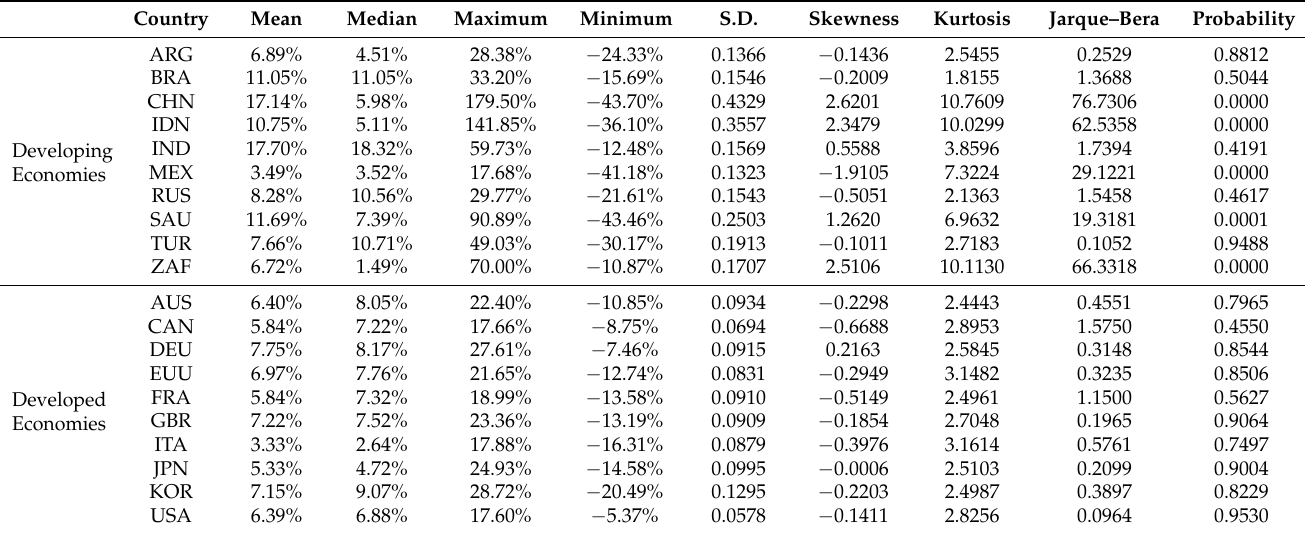
Table 4. Summary statistics of the commercial service export growth rate for the G20 countries from 1996 to